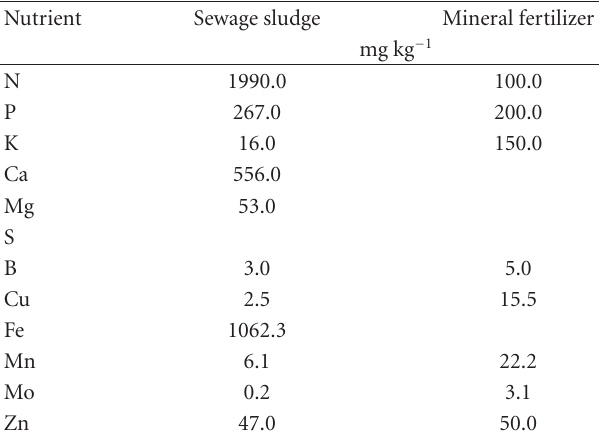
Table 3: Nutrients applied with sewage sludge and mineral fertilization to soil samples before peanut